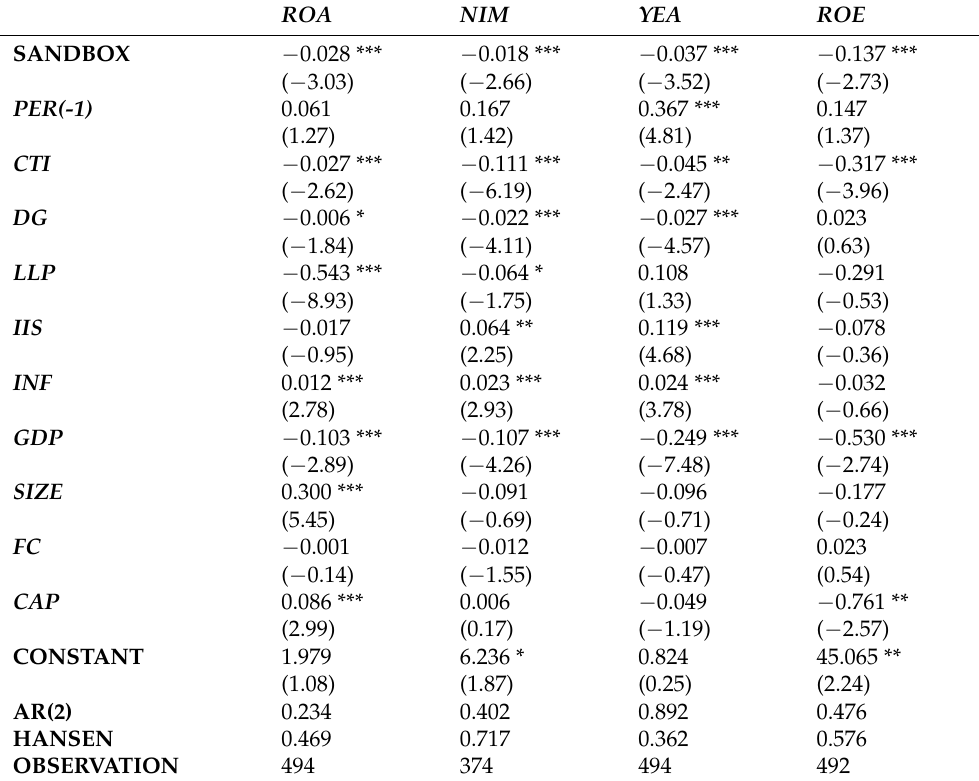
Table 5. Contemporaneous effect of regulatory Sandbox on digital bank